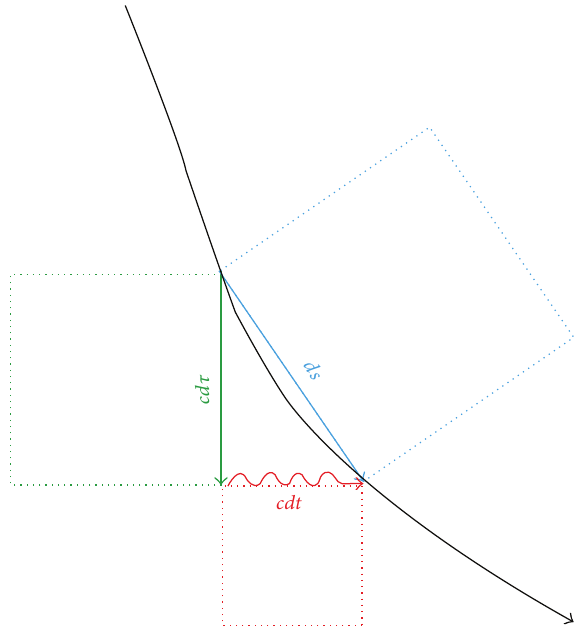
Figure 7: According to the principle of least action an infinitesimal change 𝑑𝑠 (blue arrow) in the kinetic energy ( 2𝐾 ) along the least- time path (black arrow) equates with an infinitesimal change 𝑐𝑑𝜏 (green arrow) in the scalar potential ( 𝑈 ) and infinitesimal change 𝑐𝑑𝑡 (red arrow) in dissipation ( 𝑄 ). Thus the familiar Lorentz factor 𝛾 = 𝑑𝑡/𝑑𝜏 follows when the curved least-time path is approximated by straight